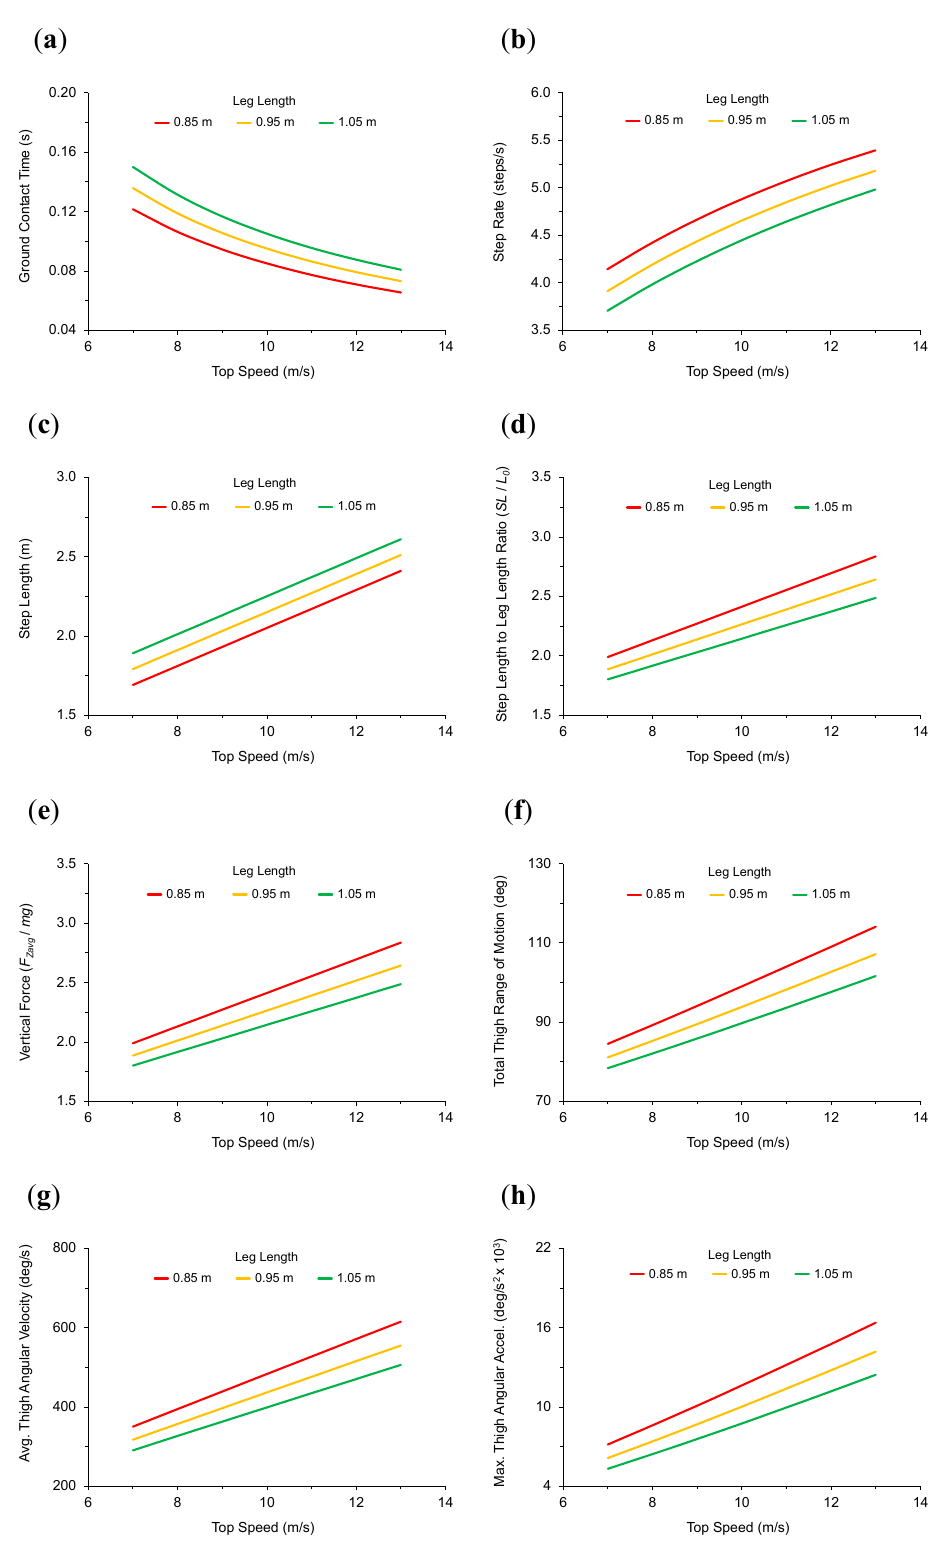
Figure 2. Calculated data across a range of top speeds for the three hypothetical athletes of different body dimensions. Illustrated lines based on values in Tables 1–3, arranged by athlete leg length ( L 0 ). ( a ) ground contact time ( t c ), ( b ) step rate ( SR ), ( c ) step length ( SL ), ( d ) ratio of step length to leg length ( SL / L 0 ), ( e ) ratio of stance-averaged vertical force to body weight ( F Zavg / mg ), ( f ) total thigh range of motion ( θ total ), ( g ) average thigh angular velocity ( ω avg ), ( h ) modeled maximum thigh angular acceleration ( α max ).